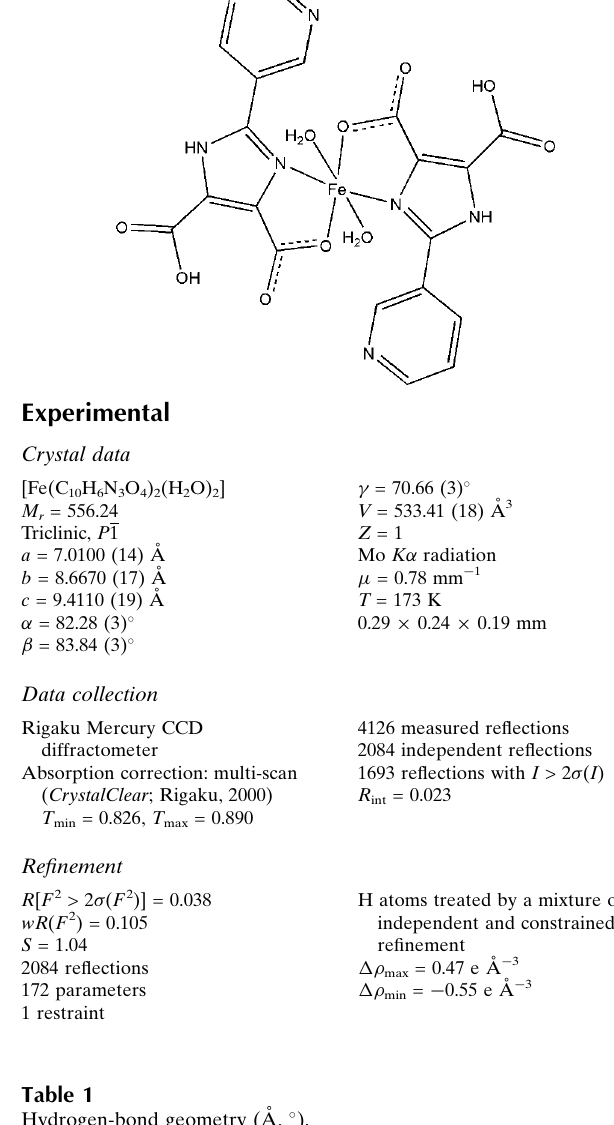
Hydrogen-bond geometry (A ˚ , (cid:3) ). D —H (cid:2)(cid:2)(cid:2) A